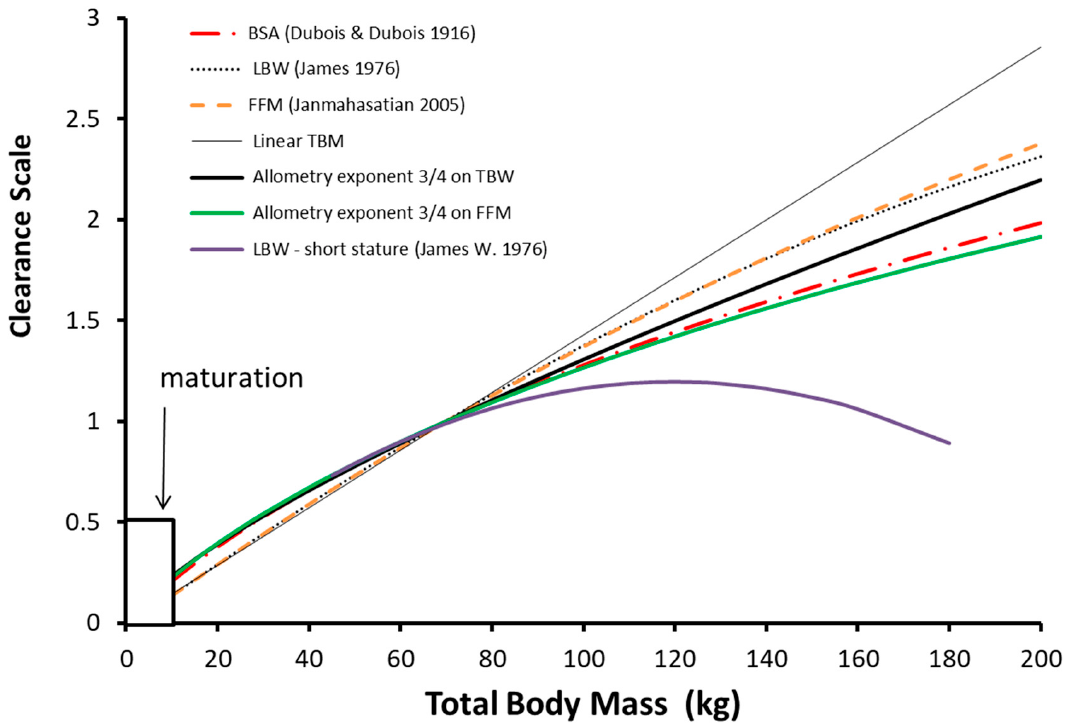
Figure 2. Clearance relative to a person of 70 kg total body mass (TBM) is shown using different size metrics. Children younger than 1 year of age (approx. 10 kg) are not shown because maturation is incomplete in that cohort. Metrics are standardized to a male with typical height for age and weight from 10 to 200 kg. A nonlinear relationship exists between weight and clearance for most body size metrics. The use of the linear per kilogram model, based on TBM, increasingly overestimates clearance in adults of weight greater than 70 kg. The use of BSA (weight with an exponent of 2/3) and allometry using an exponent of 3/4 are similar at lower masses but diverge when TBM is greater than 100 kg. Note that the James formula [57] (purple line) fails in adults of short stature with increasing total body weight [58,59].